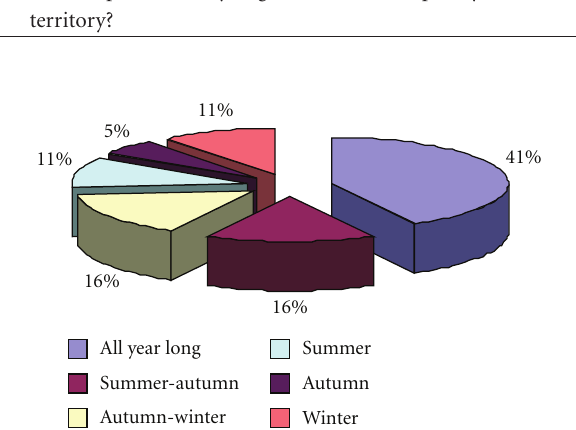
Figure 3: Period of the year in which forest grazing is practiced.